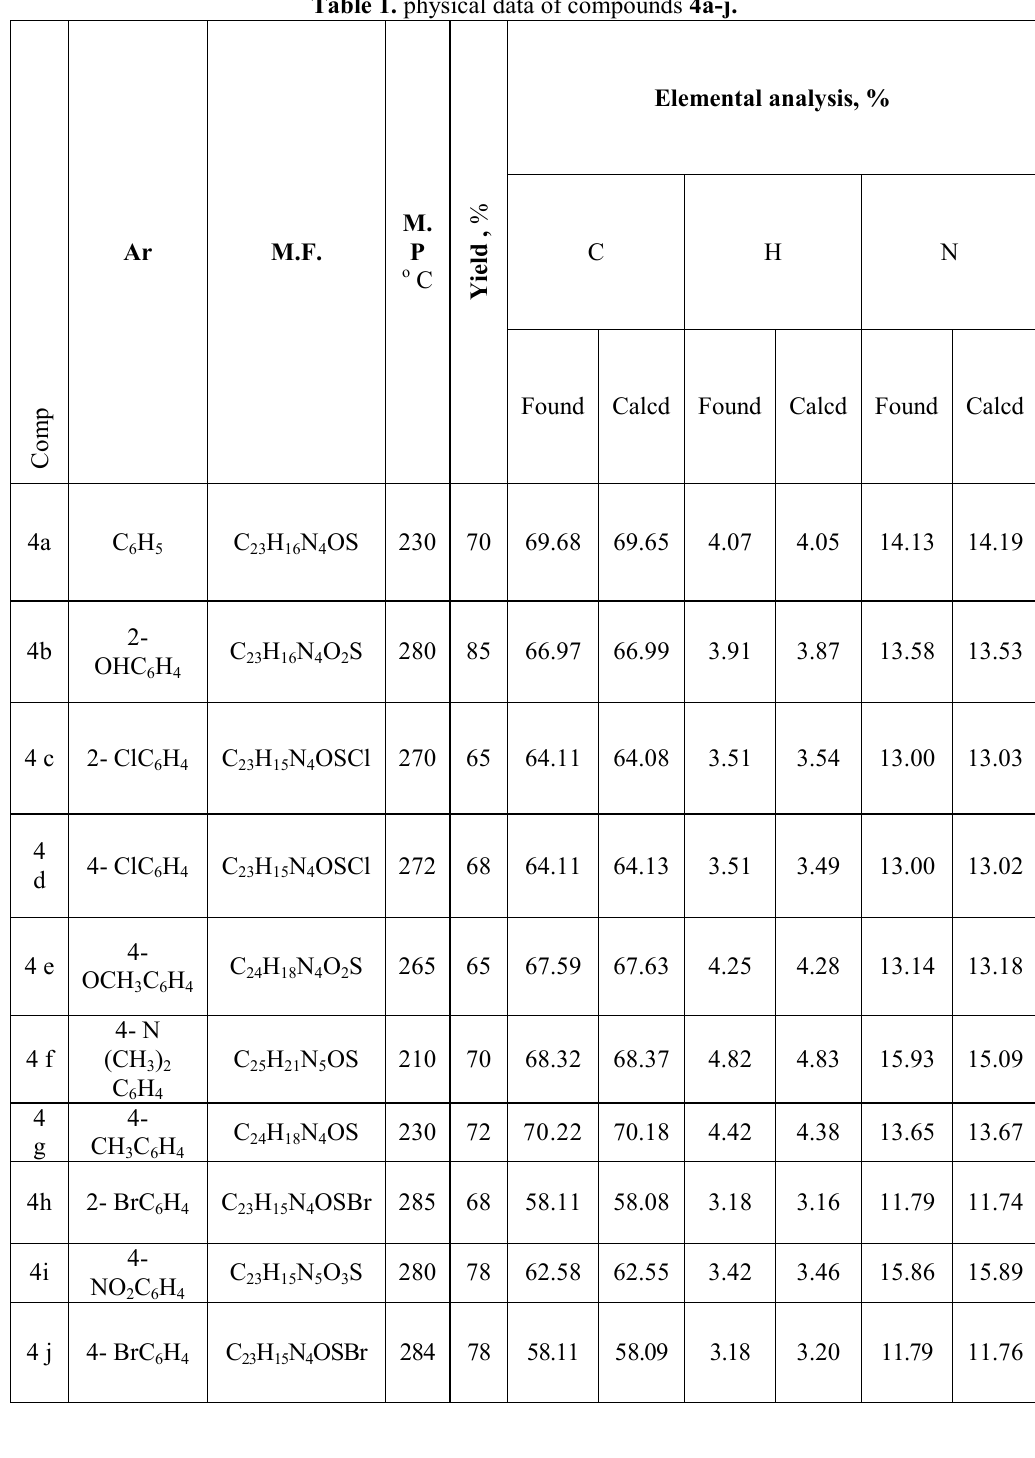
Table 1. physical data of compounds